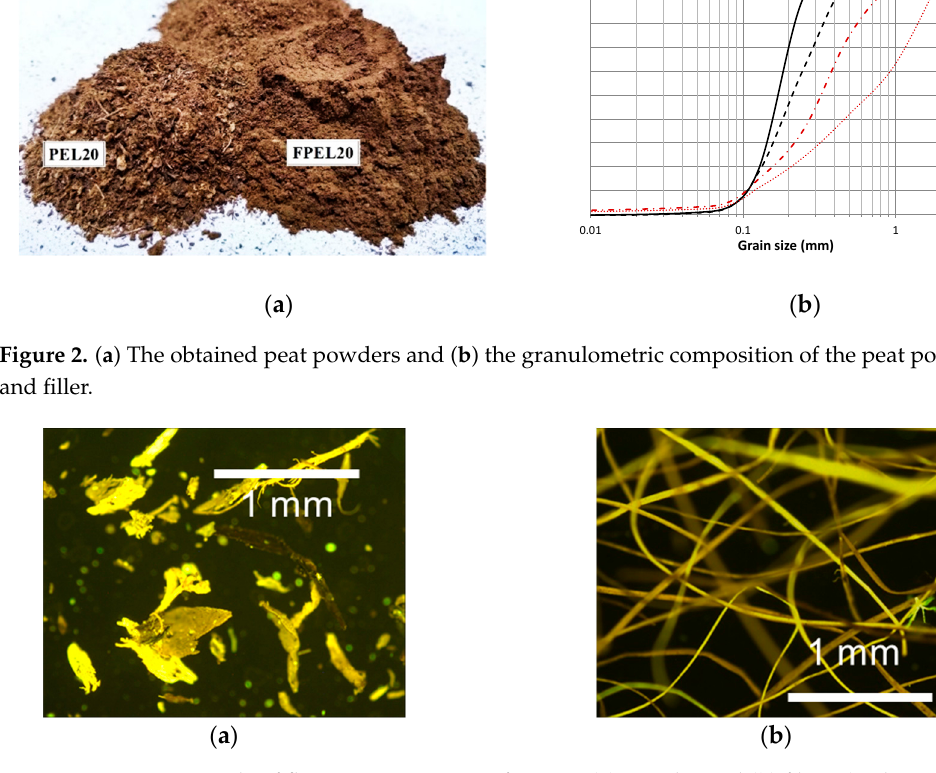
Figure 3. An example of fluorescence images of PEL20: ( a ) powder and ( b ) fibers (scale 50×).